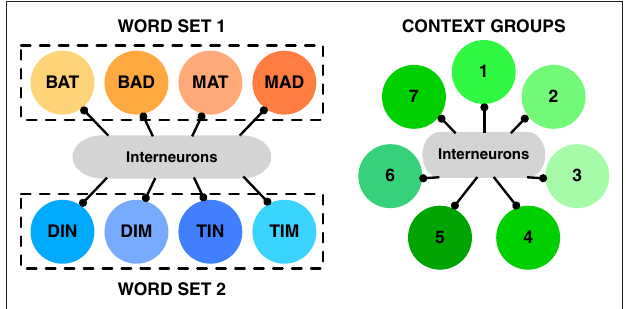
Figure 1 | Schematic representation of network architecture. (Left) Winner-takes-all network of Word Groups. Each circle represents a group of 80 excitatory cells. Cells within a group receive identical input and are connected to each other by recurrent excitation. Recurrent excitation is strong enough to enable persistent activity among cells representing a single word. Each of the two dashed boxes represents a set of four words with phonological similarity (e.g., “Bat”, “Bad”, “Mat”, “Mad”). Presentation of one word from the set excites, to a degree depending on clarity of the presented word, other words in the same set. The two-word sequence consists of a stimulus from Set one then from Set two. The winner-takes all character of the word-identification network is produced by cross-inhibition between different word groups via interneurons (20 inhibitory cells per excitatory pool). The cross-inhibition is significantly stronger than weak cross-excitation (not shown) such that after presentation of a stimulus only one group of cells – typically the group most strongly activated by the stimulus – can remain significantly active. (Right) Winner-takes-all network of Context Groups. Symbols have the same meaning as for the Word Groups. Self-excitation within Context Groups is present, but less strong than for Word Groups, allowing for context to change with time while a word can be retained in memory. Seven Context Groups are simulated, again, because of cross-inhibition, just one context group is